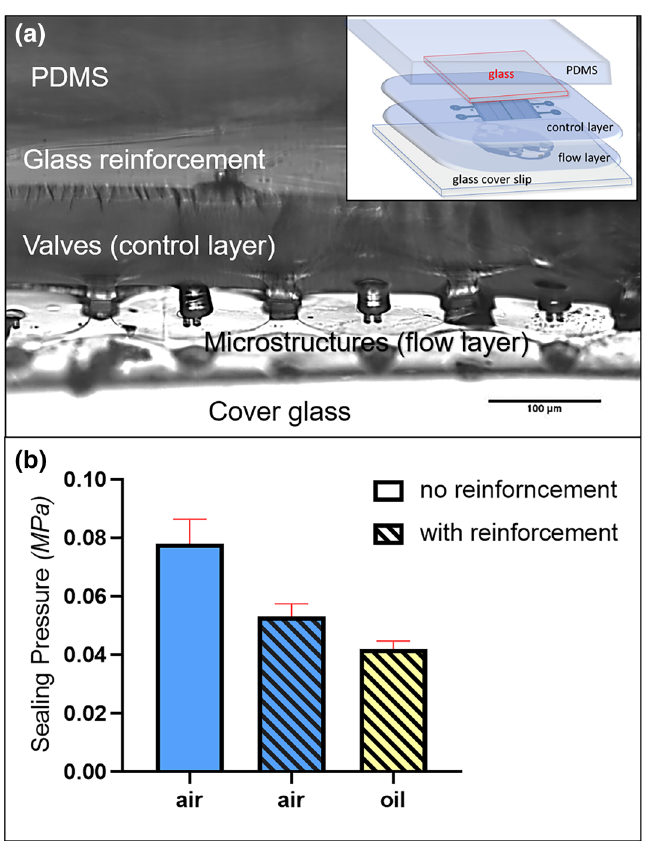
Figure 5. Reinforcement of the control layer via addition of thin glass ≈ 100 µm above the PDMS microvalves ( a ) cross-section image of the microfluidic device, inset: by-layer composition illustration ( b ) comparison of the sealing pressures at varying conditions (n =